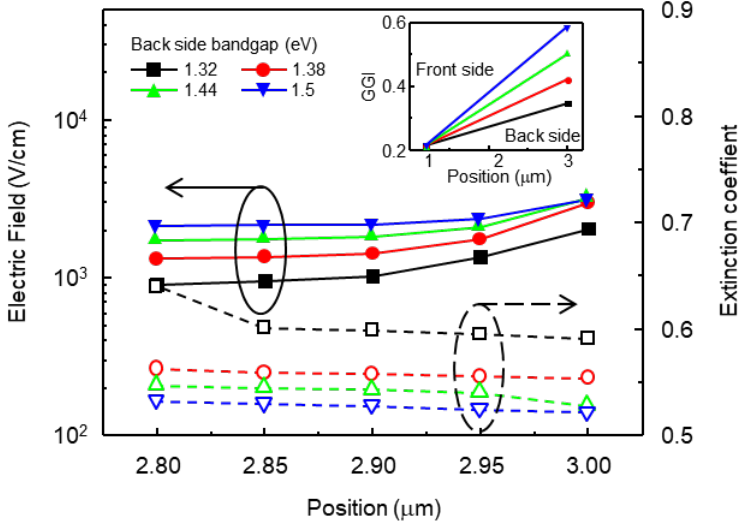
Figure 4. Electric field and extinction coefficient at the position in CIGS cell as a function of the back side bandgap.